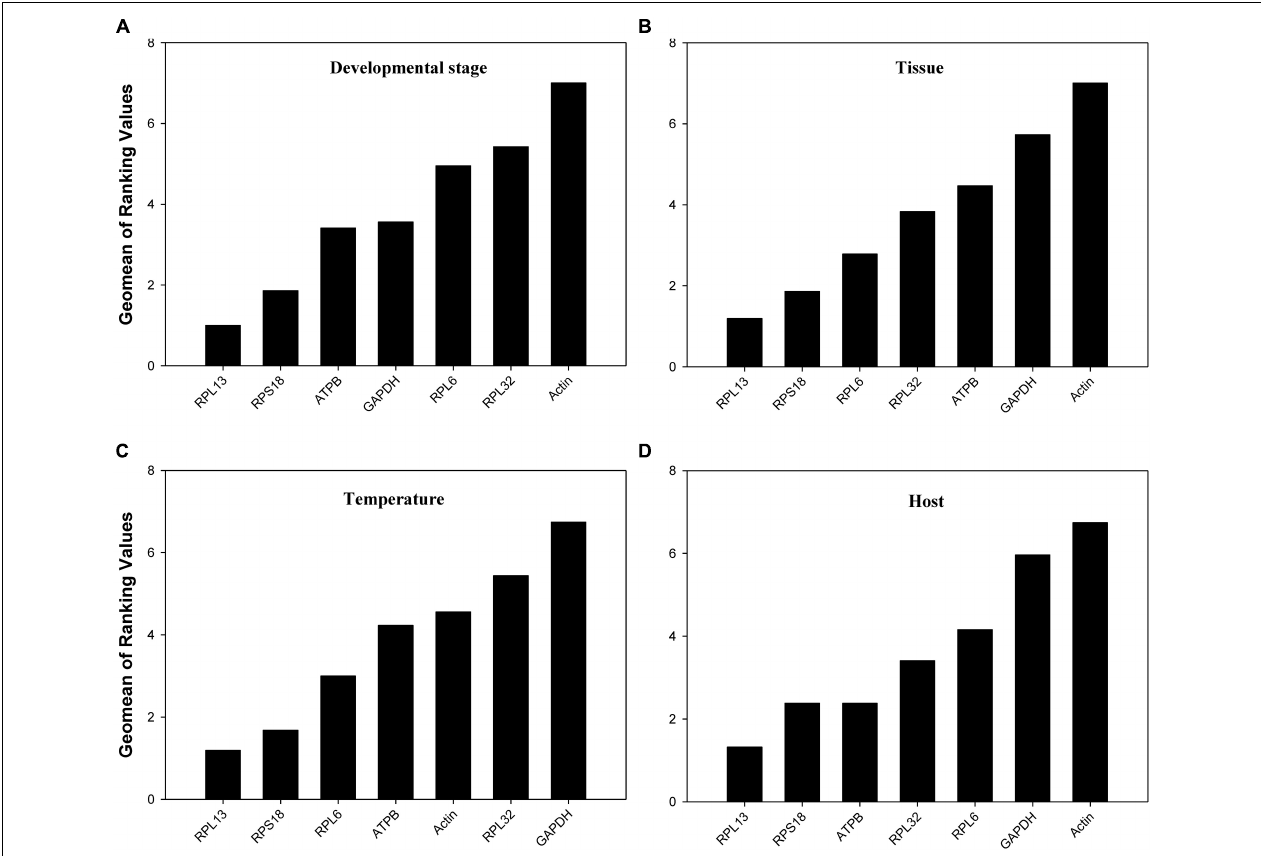
FIGURE 3 | Stability of the 7 candidate reference gene expressions in H. vigintioctomaculata under different treatment conditions analyzed using RefFinder . (A) Development stage, (B) Tissue, (C) Temperature, (D) Host plant.